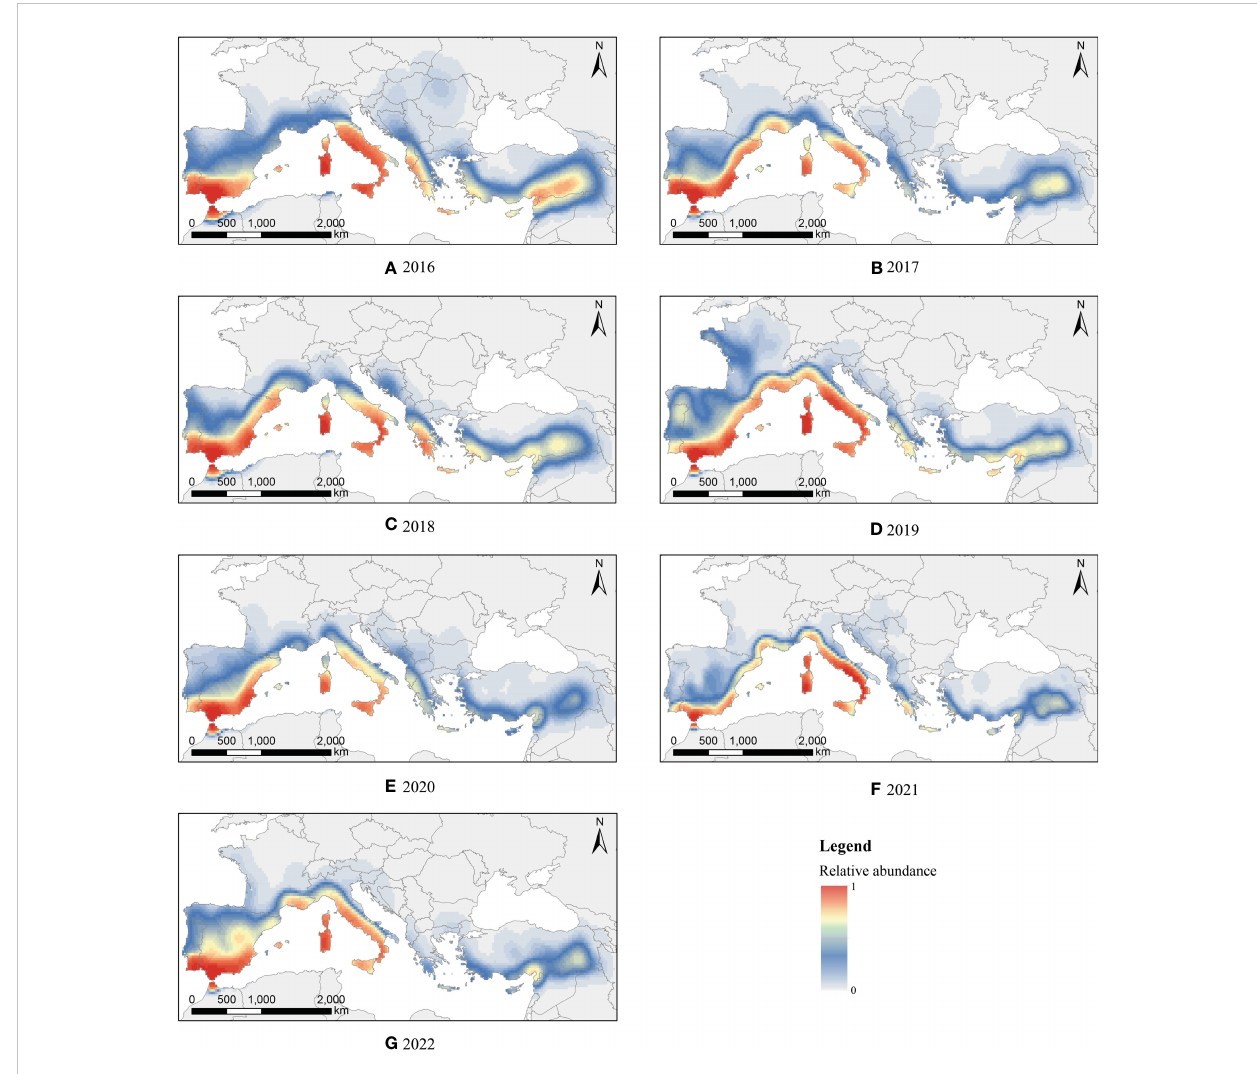
FIGURE 3 Invasion risk distribution of FAW in southern Europe from (A – G) : 2016 to